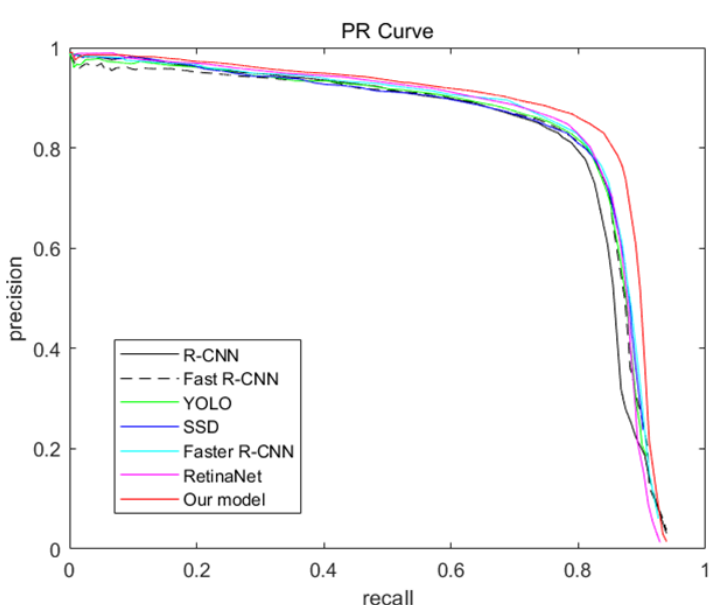
Figure 10. The PR curves of the seven tested methods. Table 2. Detection performance (Recall) of the seven tested methods using the LifeCLEF test set.